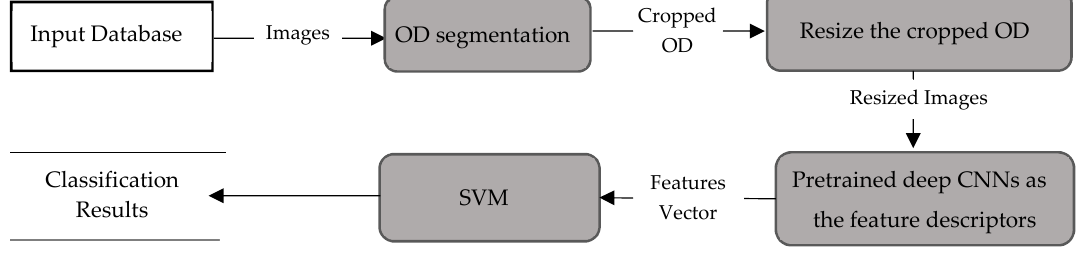
Figure 6. Data flow for method P2.